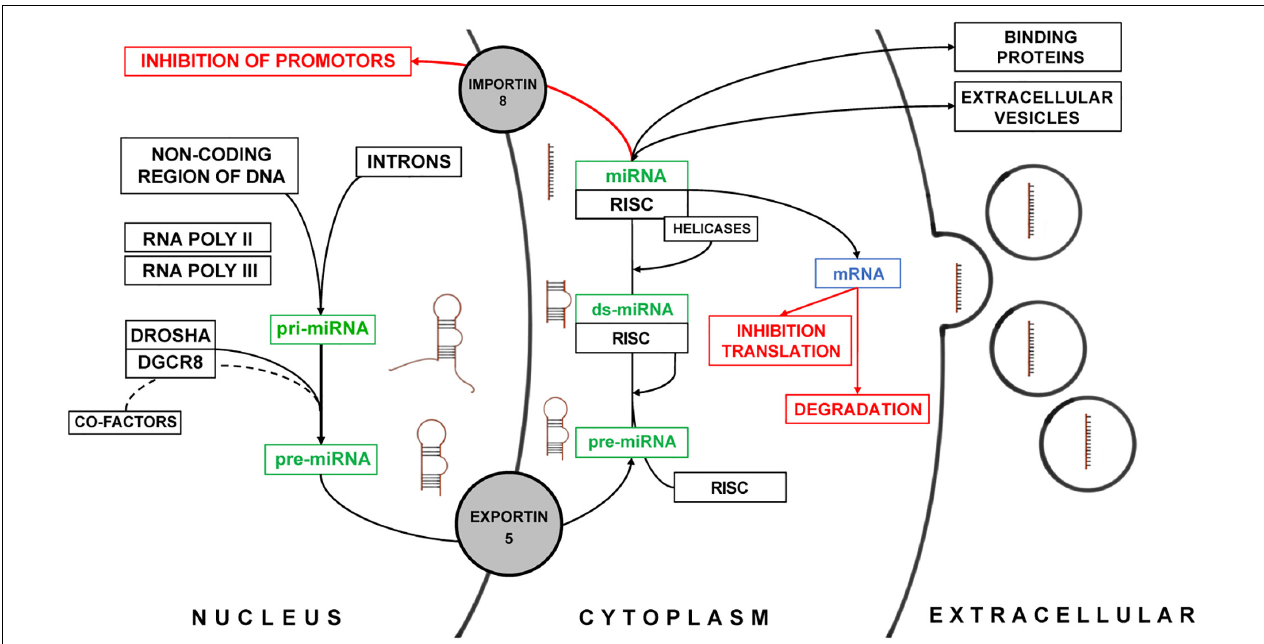
FIGURE 1 | Summary of the biosynthesis and the biological effect of miRNAs. The different stages of miRNA are schematically depicted next to the green description of miRNA. The biological effect of miRNAs is marked in red.